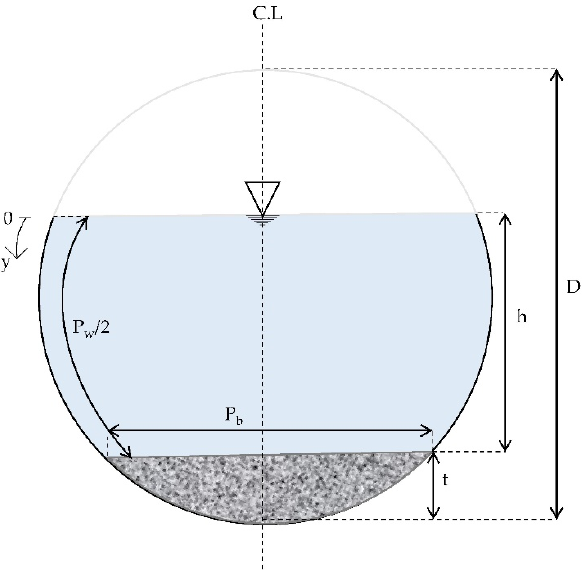
Figure 1. Cross-section of a circular channel section with a flat bed and its notation. In Figure 1, D is the diameter of the channel, t is the height of the flat bed, and h is the water depth. P w is the wetted perimeter of the channel wall and P b is the wetted perimeter of the channel bed, and their summation is equal to P . Therefore, the wetted perimeter of bed and wall of the channel is calculated at different heights of ( h + t / D ) ratios. The shear stress values are only computed for half the wetted perimeter due to section